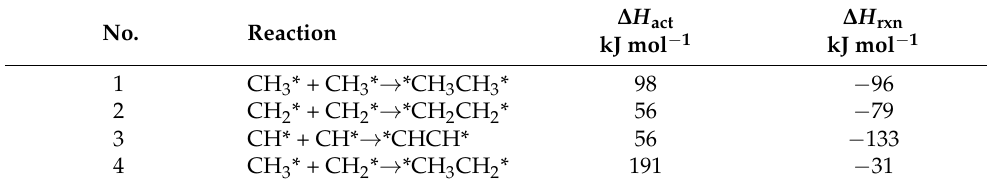
Table 3. DFT-predicted forward activation enthalpy ( ∆ H act = H TS − H reactants ) and enthalpy of reaction ( ∆ H rxn = H products − H reactants ) for the C–C coupling reactions on Ni 2 P(001) at 1123